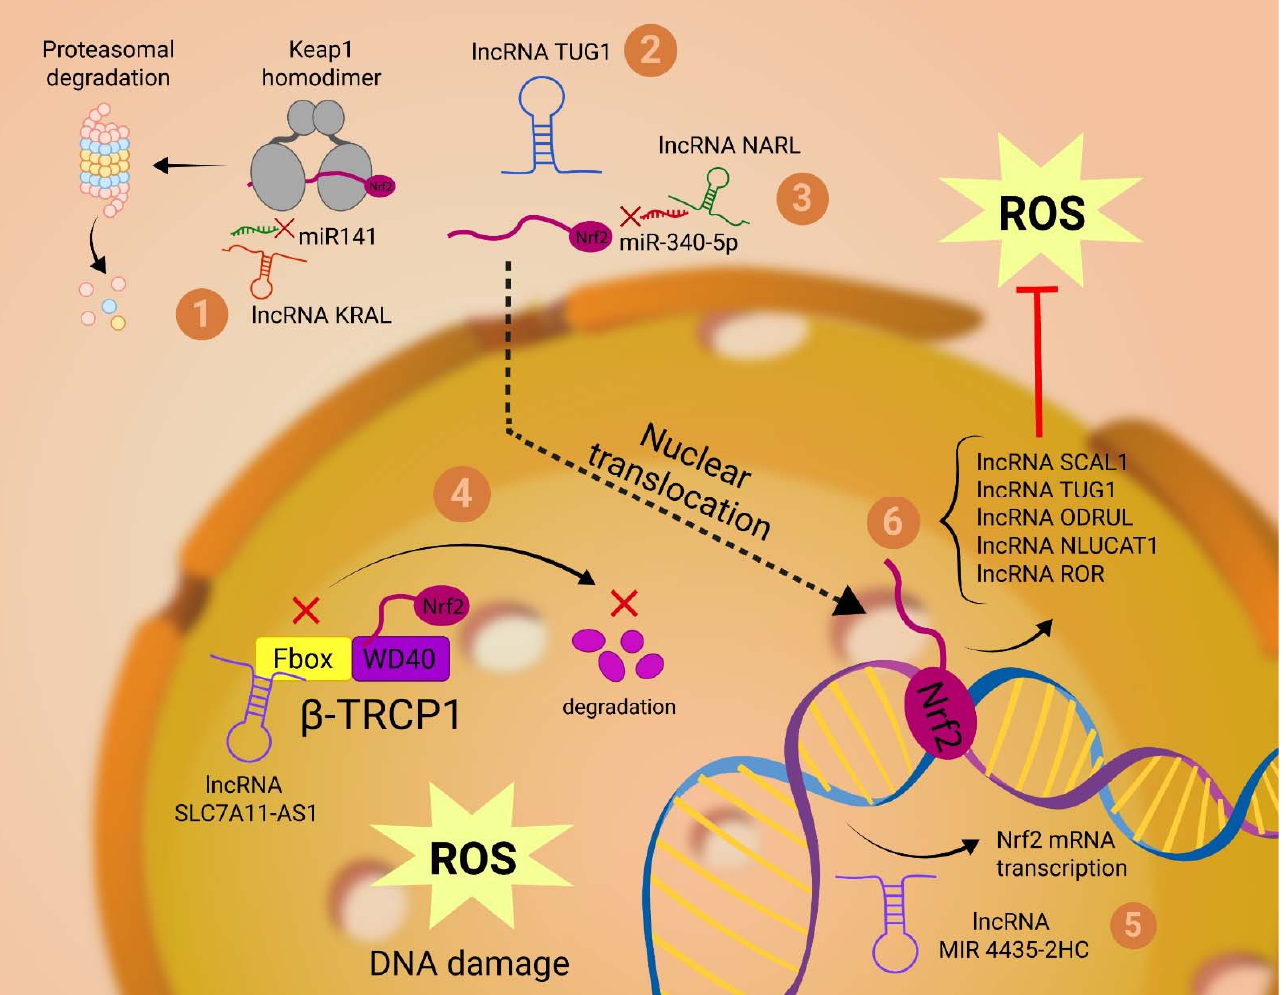
Figure 3. Nrf2-associated lncRNAs: As regulators of Nrf2, lncRNAs can act both at the cytoplasmatic and the nuclear level. In the cytoplasm, lncRNA KRAL and lncRNA NARL act as ceRNAs for miR 141 and miR-340-5p, respectively. While KRAL promotes Nrf2 proteasomal degradation by freeing up the KEAP 1 homodimer (1), NARL prevents Nrf2 inactivation in the cytoplasm and facilitates its translocation to the nucleus (2). At the cytoplasmatic level, lncRNA TUG1 directly binds to the Nrf2 protein and potentiates its activity (3). In the nucleus, lncRNA SLC7A11-AS1 prevents the recruitment of β -TRCP1 to the SCF β -TRCP E3 complex, which would otherwise initiate ubiquitination and proteasomal degradation of Nrf2 in the nucleus (4). LncRNA MIR4435-2HG induces Nrf2 gene expression and subsequent transcription into mRNA (5). Nrf2 induces the transcription of multiple lncRNAs that regulate the level of ROS (6).